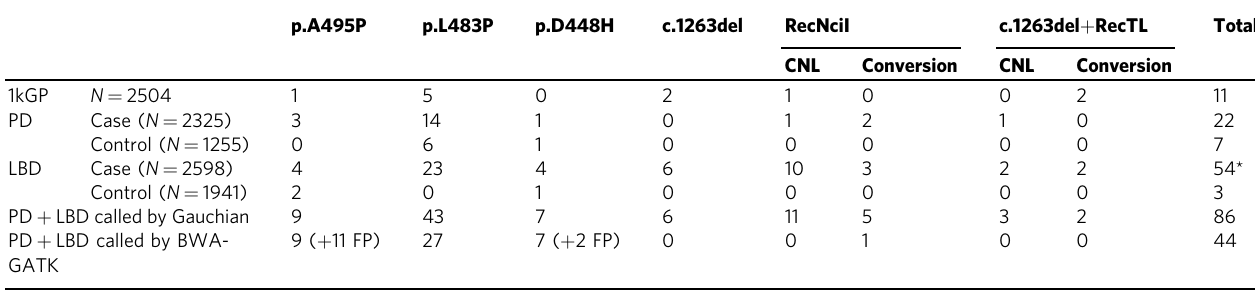
Table 3 GBAP1 -like variants in the exons 9 – 11 homology region in 1kGP, PD and LBD